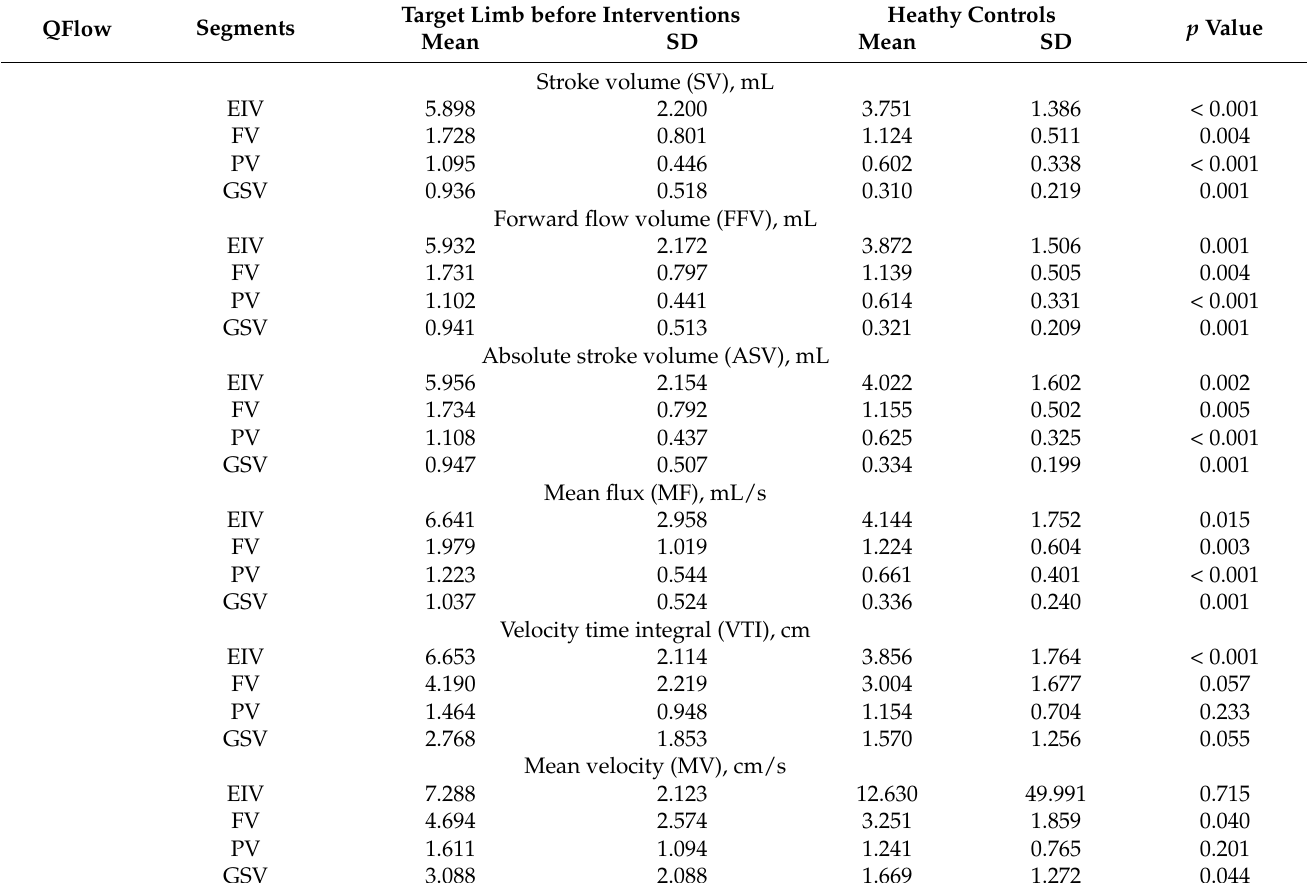
Table 2. Hemodynamics parameter between target limb (before intervention) and healthy controls.